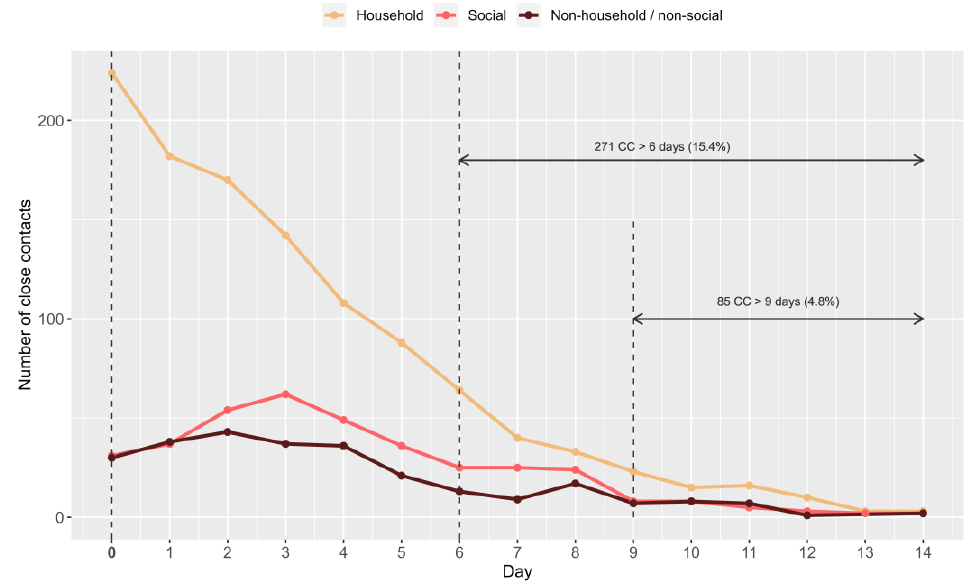
Figure 4. Temporality of symptom onset from the close contact (CC) date of last date of exposure with the index case (IC) by setting of